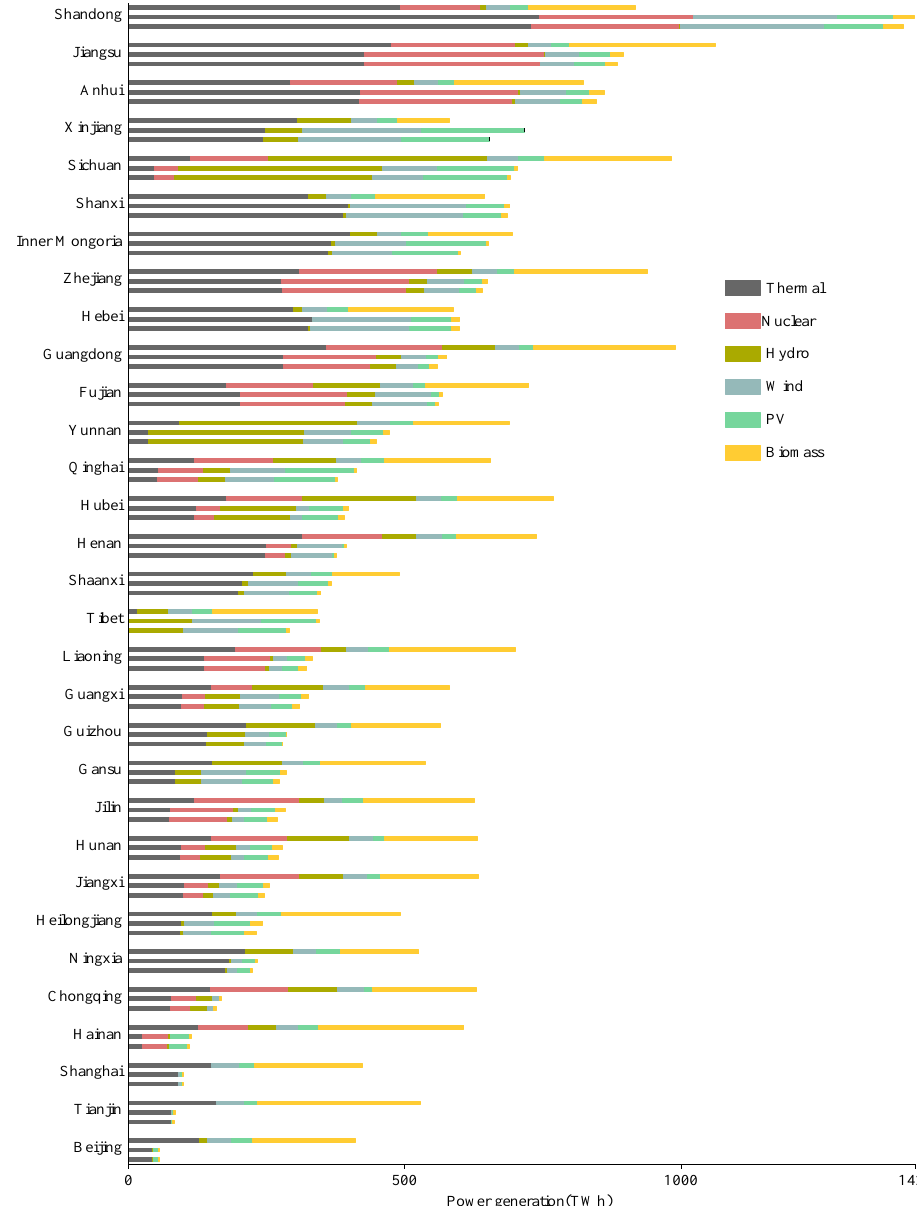
Figure 10. Optimal Power Generation Structure in Different Economic Growth Scenarios in 2040. (Three bars of each province correspond to the HGDP, BAU, and LGDP economic growth scenarios, from top to